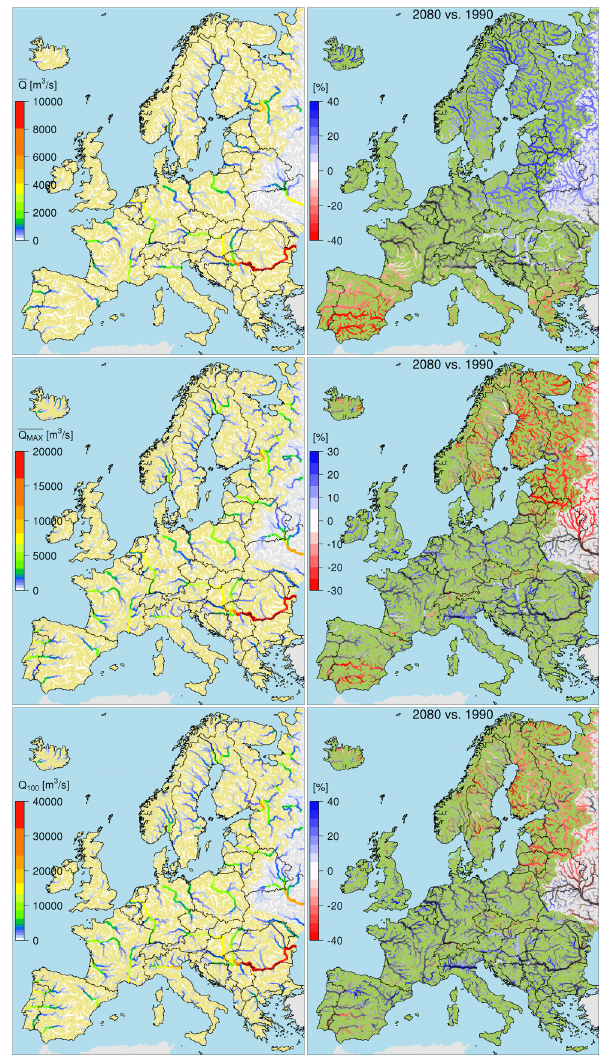
Figure 6. Average streamflow Q (top), mean annual daily peak flow Q MAX (centre) and 100-year daily peak flow Q 100 (bottom). En- semble mean of the baseline (1976–2005) and relative change for the time slice 2066–2095. Data points with CV > 1 are greyed